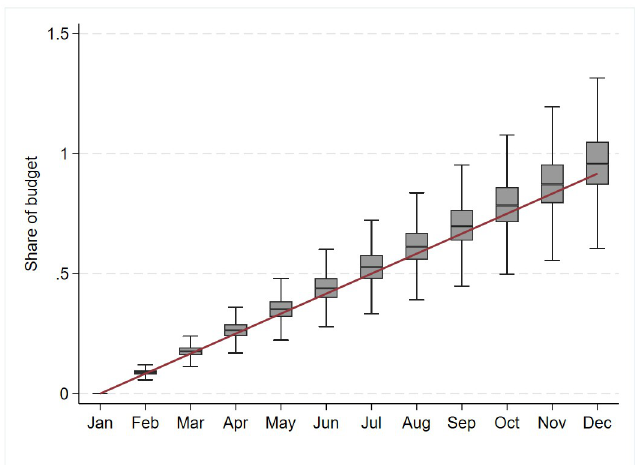
Fig 2. Municipalities’ expenditure as share of the budget, 2007–2016. Budget share is measured at the beginning of the month. For January, the budget share is always zero. For February, the budget share is defined as the proportion of the total budget for year t that was used in January. For March the budget share is calculated as the share of the January and the February expenditure out of the total budget, etc. Finally, for December, the budget share is defined as expenditure share of the months January to November in that year. The red line indicates the expected budget share, if the expenses were equally distributed across the months.